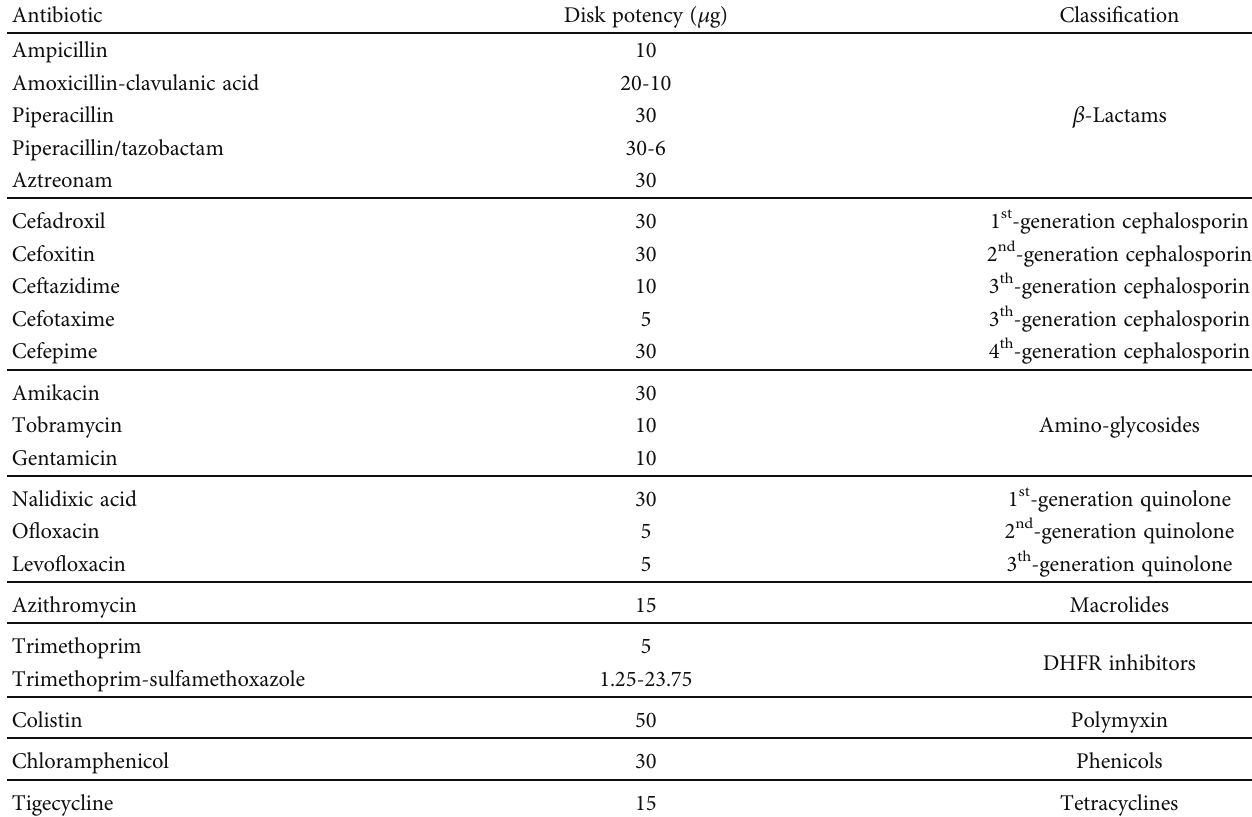
Table 1: List of the antibiotics selected and their